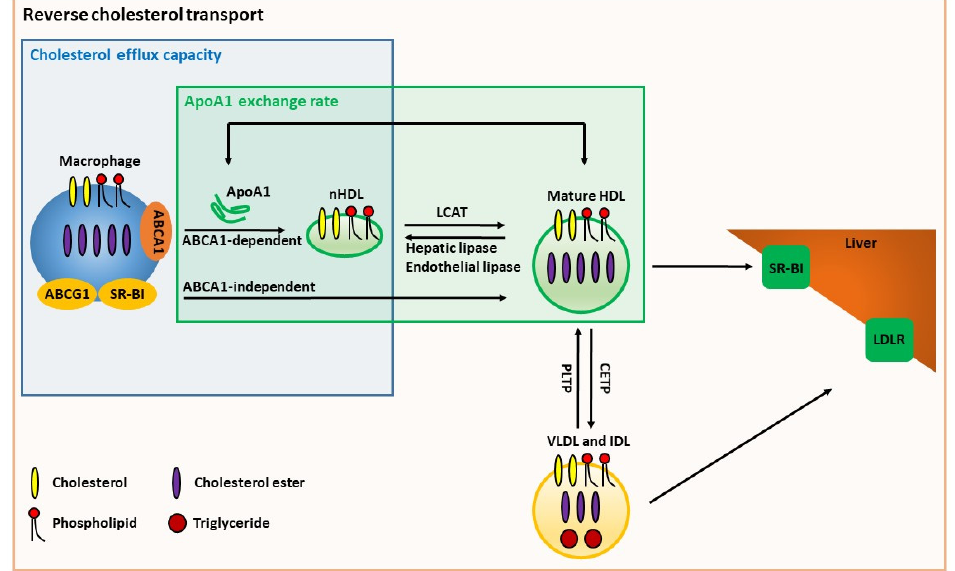
Figure 1. Assays for HDL function that represent the role of HDL in reverse cholesterol transport and HDL remodeling. The cholesterol efflux capacity assay uses human apoB-depleted serum as an acceptor for macrophage cholesterol and phospholipids. ABCA1 mediates cellular cholesterol and phospholipid efflux onto serum lipid-poor apoA1 leading to the formation of nHDL, which represents the ABCA1-dependent cholesterol efflux capacity. Serum HDL can accept more cholesterol and phospholipid through ABCG1, SR-BI, and aqueous diffusion, which represents the ABCA1-independent cholesterol efflux capacity. This assay can distinguish between ABCA1-dependent and -independent cholesterol efflux when using mouse macrophages as the donor cell type. The apoA1 exchange-rate assay is a cell-free in vitro assay in which human apoB-depleted serum or plasma is incubated with exogenously labeled apoA1, and apoA1 is freely exchangeable between labeled lipid-free apoA1 and serum HDL. The rate of exchange of the labeled apoA1 is an indicator of HDL remodeling and is correlated with plasma HDL and apoA1, as well as with the cholesterol efflux capacity. ABCA1: ATP-binding cassette transporter A1; ABCG1: ATP-binding cassette transporter G1;